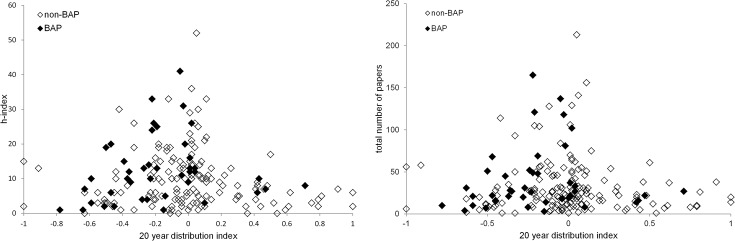
Publication metrics plotted against 20 year distribution change index (distribution change between 1988–1991 and 2008–2011 allowing for biases in recording effort; Balmer et al. 2013), grouped by BAP status.A positive value indicates range expansion, a negative value a contraction. Note, this index was available for 195/225 species. a) total number of papers; b) h-index.